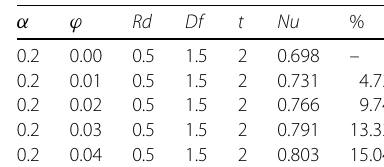
Figure 13 Variation in Nusselt number for the volume fraction